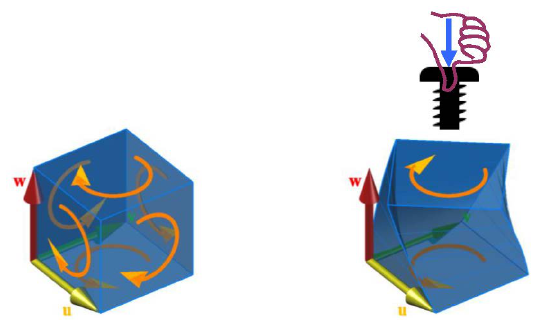
Figure 30: Relationship between the inner orientation of a cube and the orientation of a